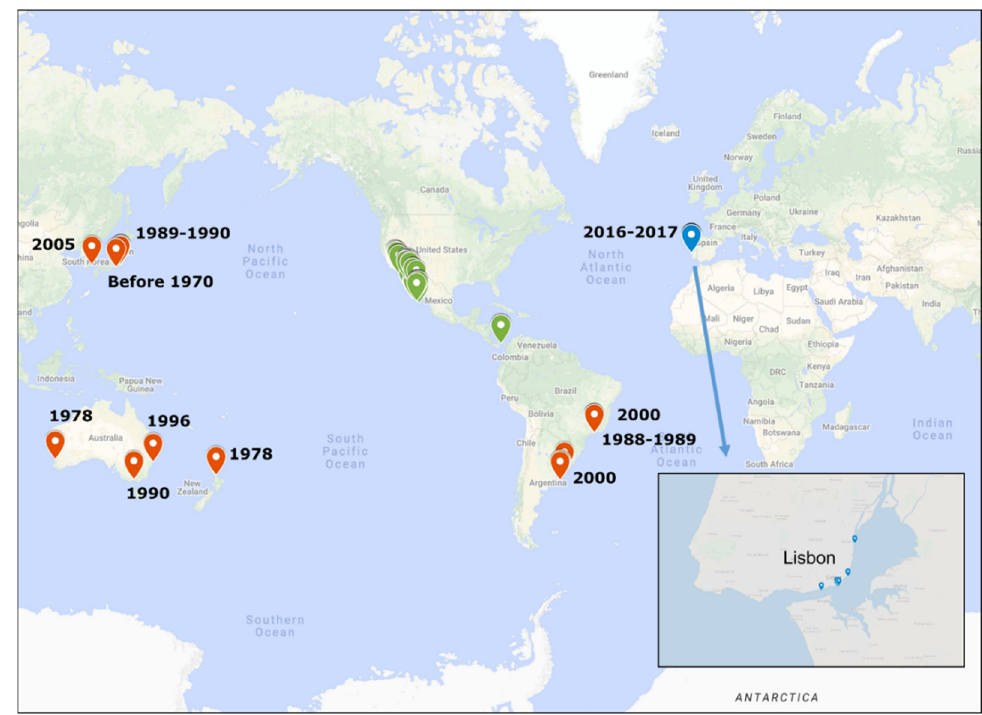
Figure 1. Location and date of collection of P. tuberculata specimens. Green pinpoints: native locations; orange pinpoint: non-native locations; blue pinpoints: new records. Available geographical coordinates were used for the United States, Mexico, and Panama [2], Japan and South Korea [3,6–8], Australia and New Zealand [9–12], and Argentina and Brazil [13,14]. The map was created using Google Map Maker (https://www.google.com/maps/d/) (1 March 2020) and edited with GNU Image Manipulation Program (GIMP) 2.10.8.